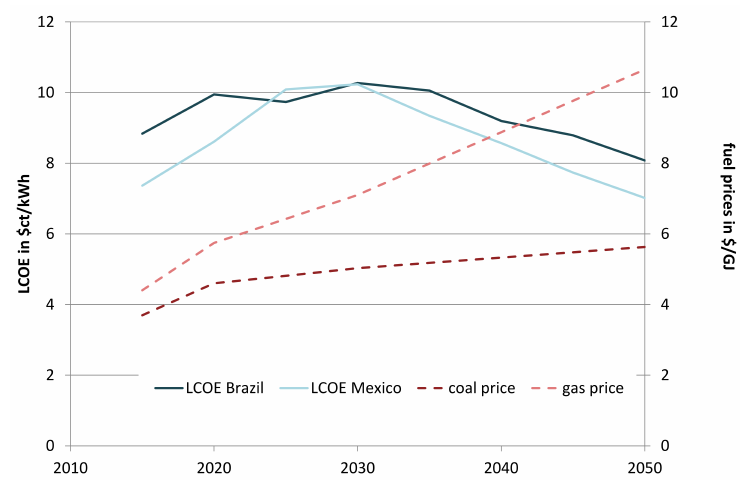
Figure 6. Development of fuel costs and LCOE for Mexico and Brazil in